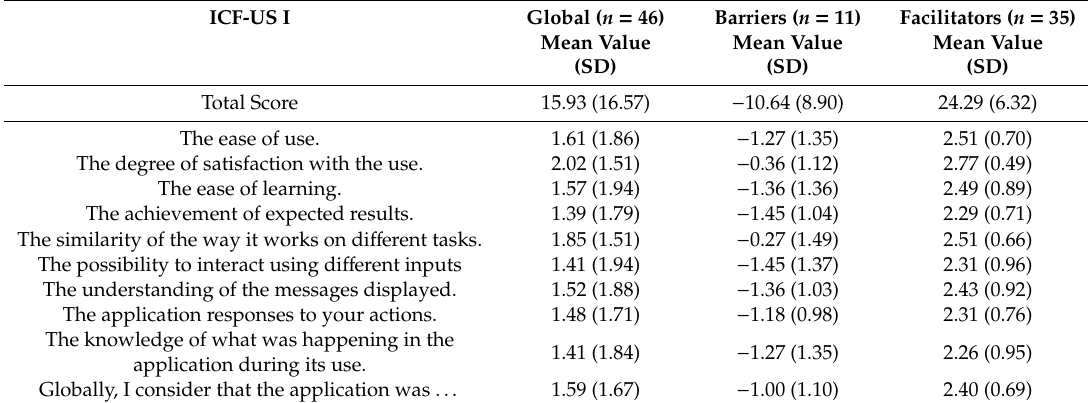
Table 3. Results of the application of ICF-US I.